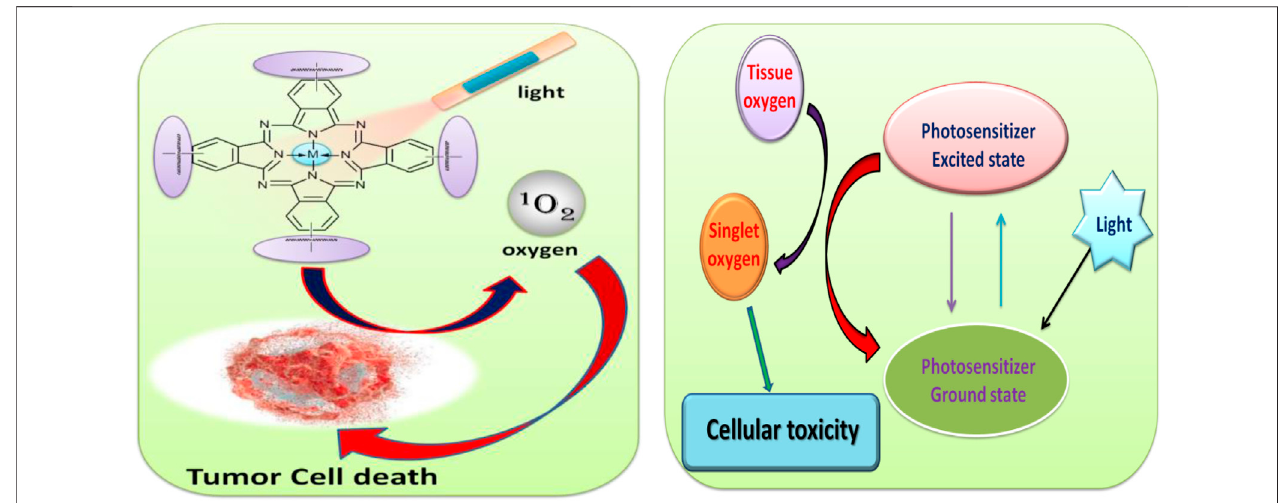
FIGURE 1 | Schematic illustration for the application of phthalocyanine in photodynamic therapy study (PDT).